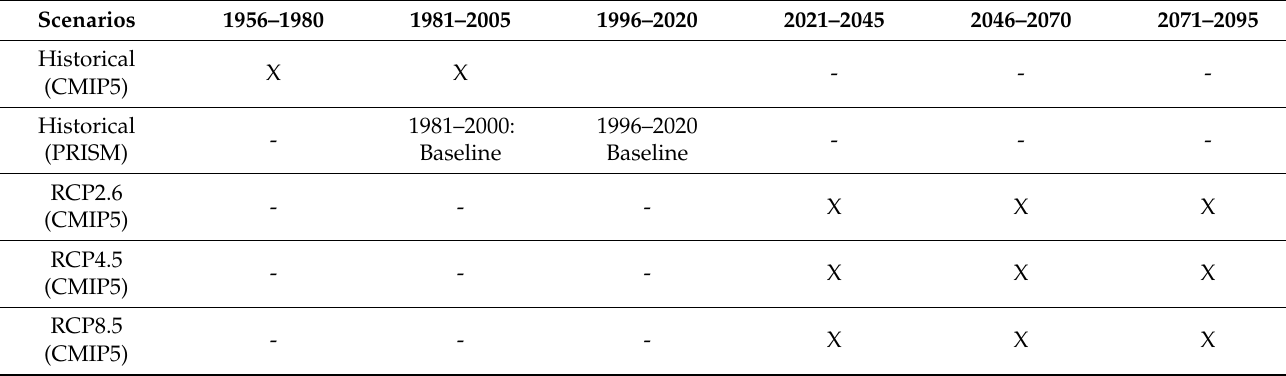
Table 3. Specific climate scenarios included in this